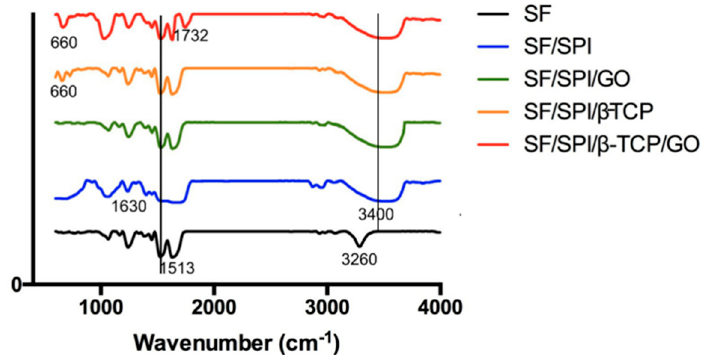
/ SPI-based composite sca ff olds.